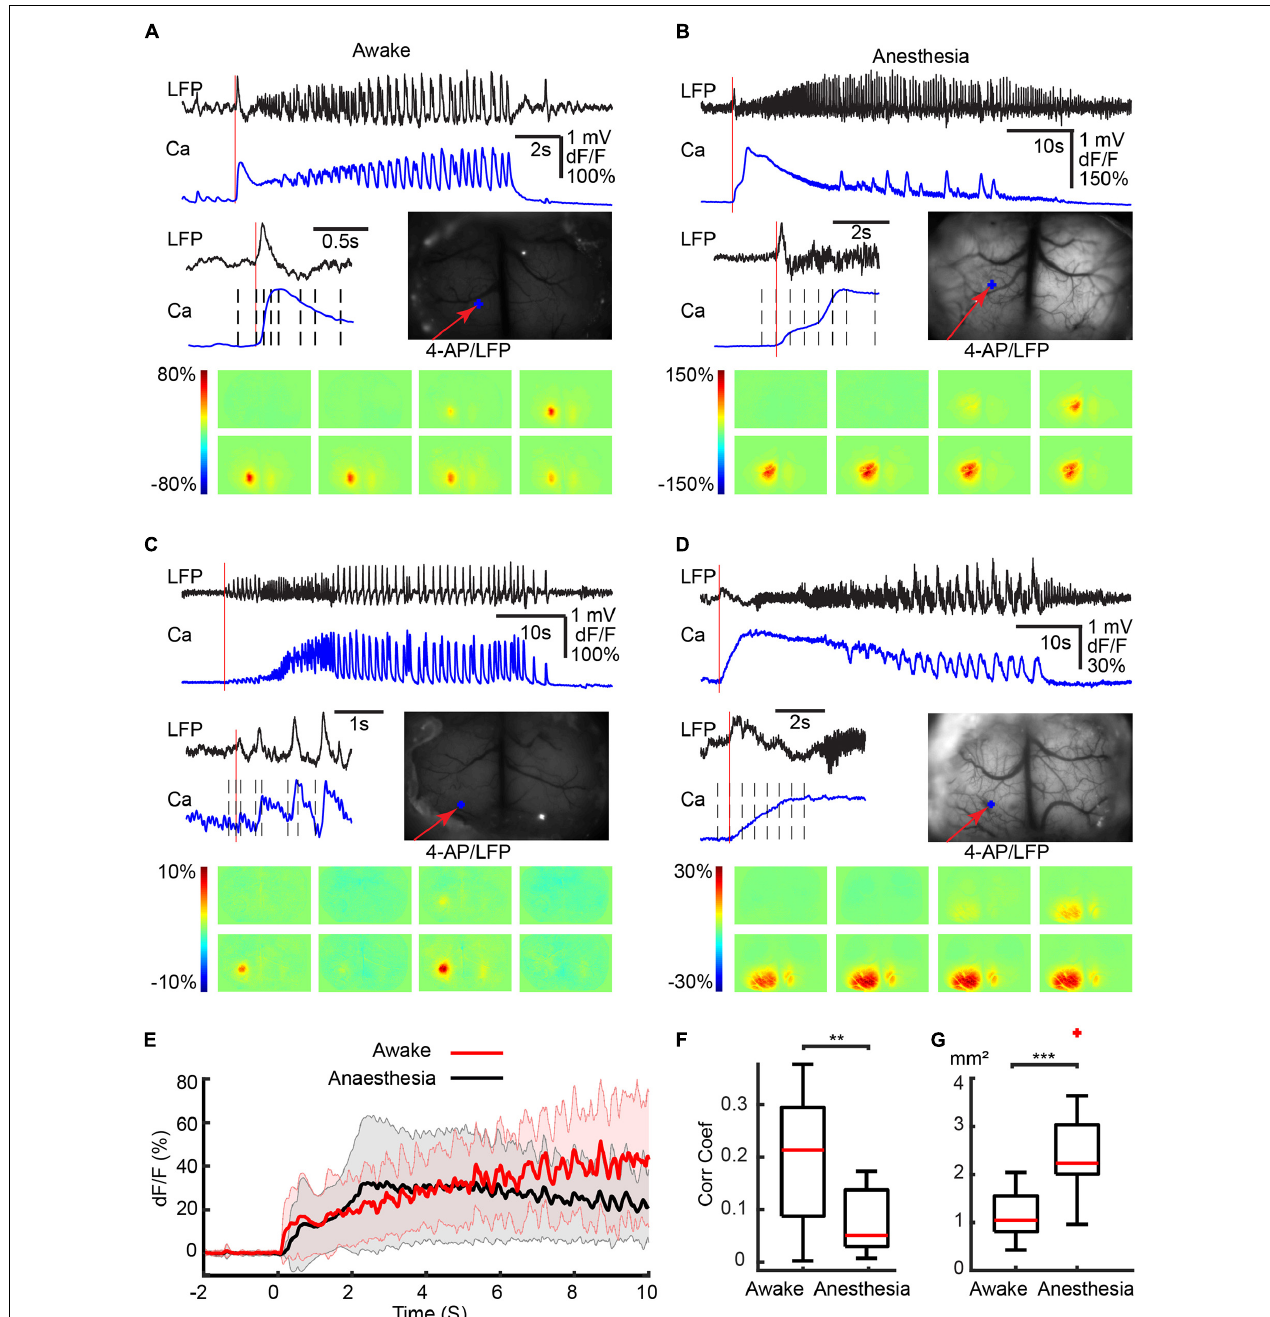
FIGURE 1 | Different initiation patterns of ictal events in awake and isoflurane-anesthetized animals. Calcium imaging of different ictal initiated patterns in four separate animals. (A) awake with a first spike. (B) Anesthetized with a spike. (C) Awake without a first spike. (D) Anesthetized without a first spike. For each panel, the top shows the LFP and calcium traces recorded at the 4-AP injection site. An enlarged view of the initiation section and the field of view are shown in the middle. The vertical red line indicates the onset of the ictal event. The black dashed lines indicate the time points from which the activity maps are shown at the bottom. The red arrow shows the 4-AP injection/LFP recording electrode. The blue dots show the location where the calcium trace is recorded. (E) The average calcium trace was recorded from the 4-AP injection site. The solid line and the shaded area showed the mean ± SD of the averaged calcium trace ( n = 17 seizures in eight awake animals; n = 14 seizures in seven anesthetized animals). Note the progressive increase and shorter decay, higher temporal resolution in the calcium signal in awake animals compared with the slow decrement low temporal resolution in the anesthetized animals. (F) Box plot of the correlation coefficient between the LFP and calcium traces in awake ( n = 17 seizures in eight awake animals) and anesthetized ( n = 14 seizures in seven animals) mice. (G) Box plot of the area of calcium signal involved in the initiation of ictal events in awake ( n = 17 seizures in eight animals) compared with anesthetized ( n = 14 seizures in seven animals) mice. *** p < 0.001 and ** p <